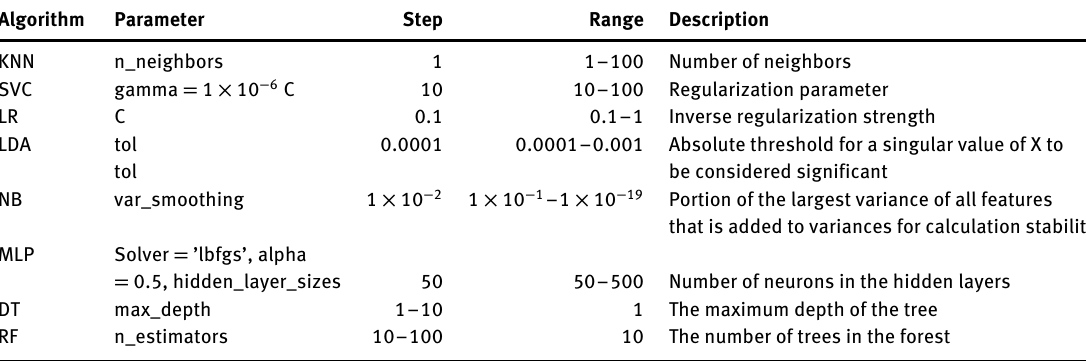
Table 1: Value ranges for the parameters based on [36].